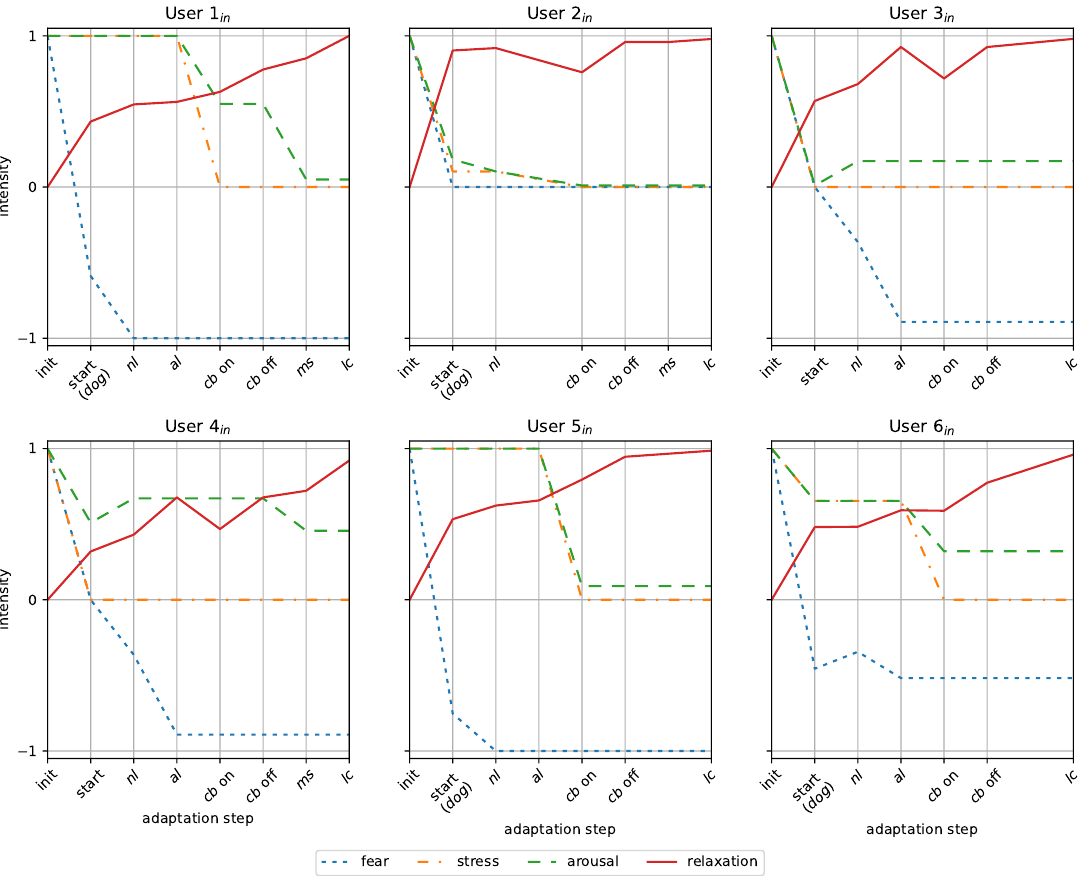
Figure 11. Plots showing the evolution of the emotional states at each time step for the indoor environment. The heuristic optimiser applies the adaptations in the same order for each